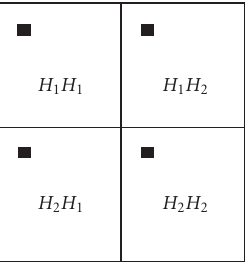
Table 2: SNRs of the denoised image which is preprocessed with repeated row